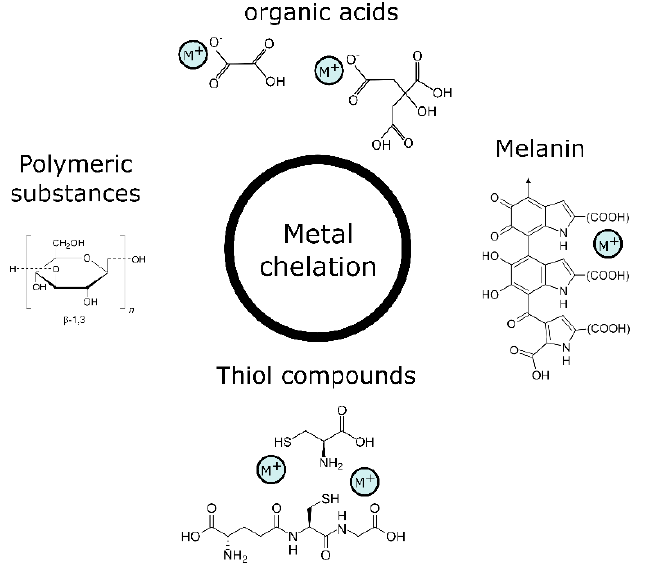
Figure 2. Metal chelation compounds.